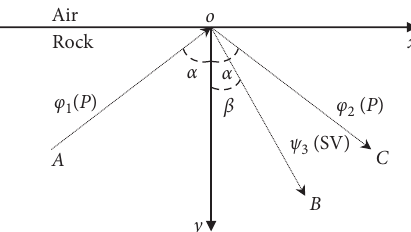
Figure 5: Propagation of acoustically emitted P-wave on rock